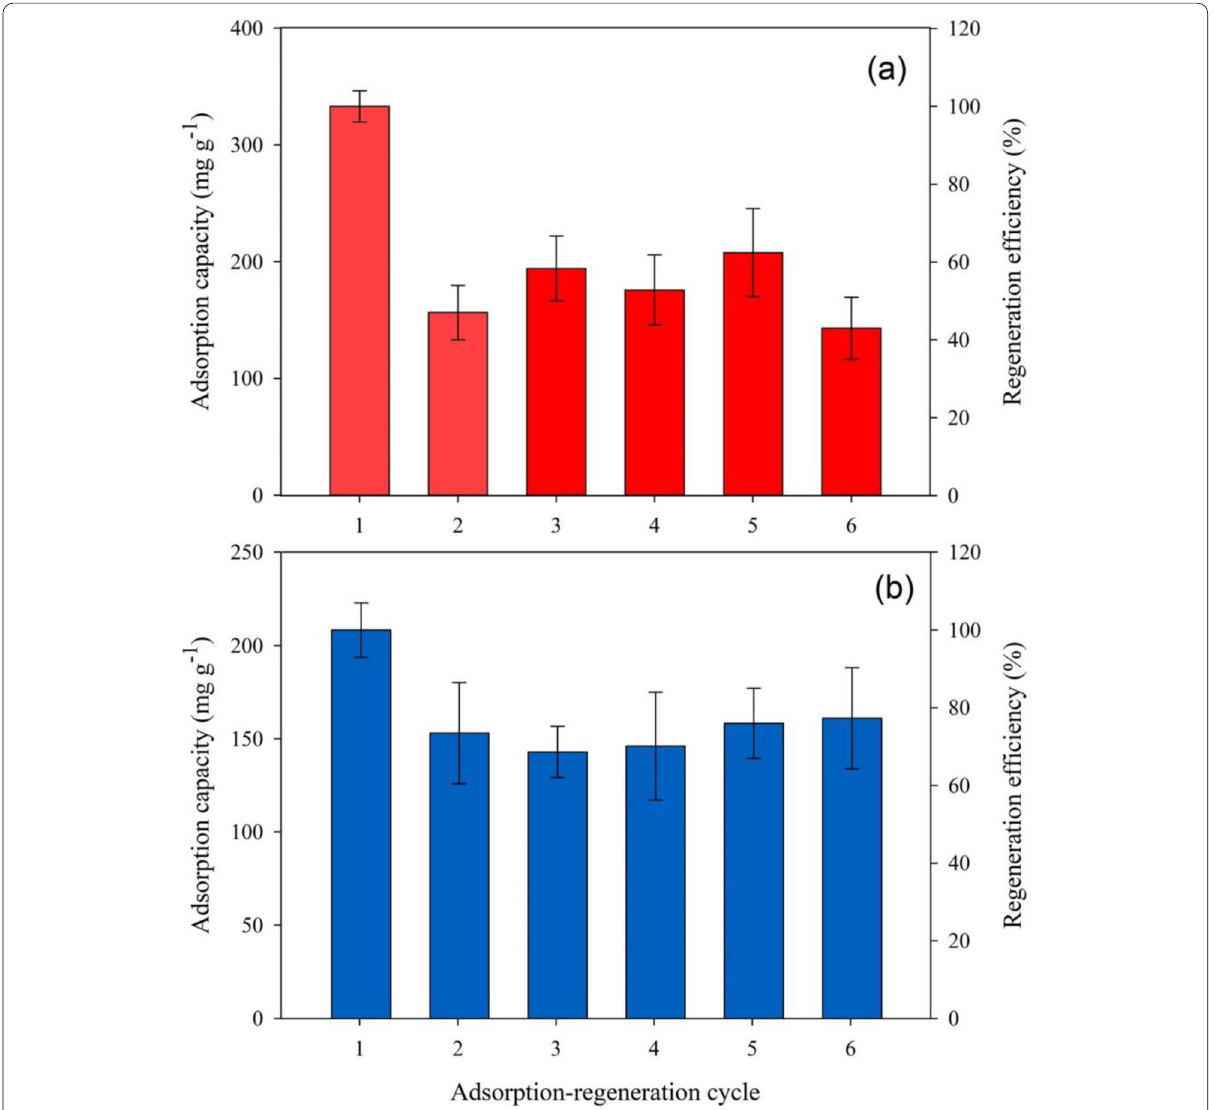
Fig. 10 Cyclic adsorption and electrothermal regeneration for a TOL‑KBAC and b MEK‑KBAC ( n